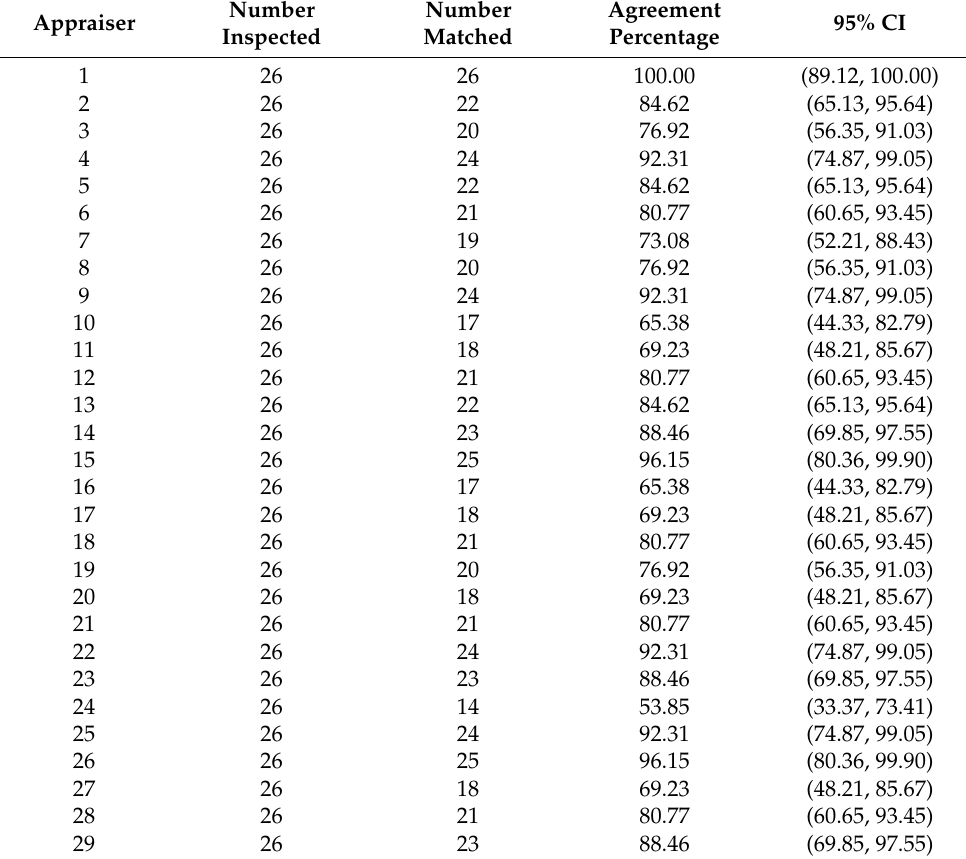
Table A1. Summary of Inspection Consistency (Agreement within